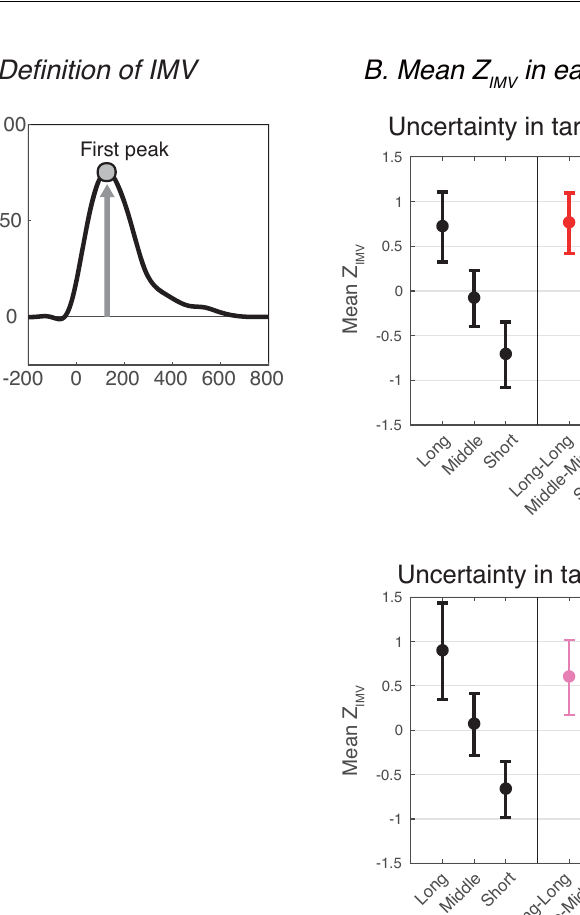
in each condition. These panels IMV